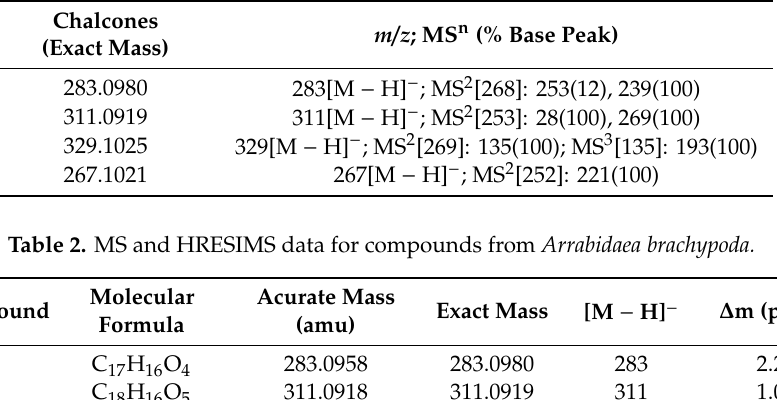
Figure 1. Chemical structure of 4’-Hydroxy-3-4-dimethoxy-chalcone ( 1 ), 3’-Hydroxy-3-acetate, 4-methoxy-chalcone ( 3 ), 3’,4’-dihydroxy, 3,4,4’-trimethoxy-chalcone ( 4 ) and 3,4-dimethoxy-chalcone ( 5 ) isolated from A. brachypoda flowers. Table 1. Multistage MS n data of chalcones by FIA-ESI / MS ion trap mass spectroscopy.